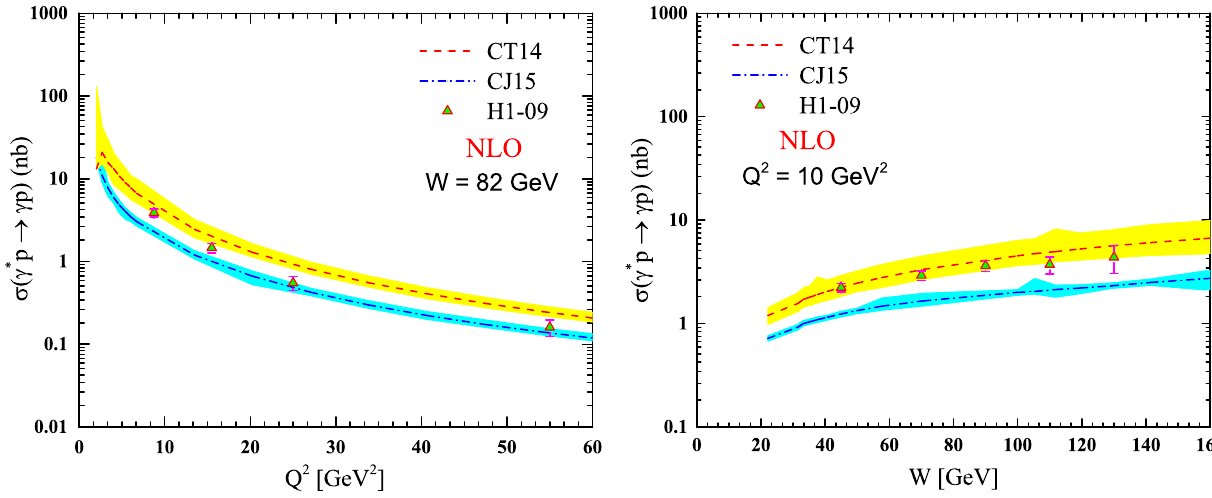
Fig. 7 The DVCS γ ∗ p → γ p cross section as a function of Q 2 (left) and W (right). Our NLO pQCD results are compared to the 2009 H1 data [79]; see for details Fig.